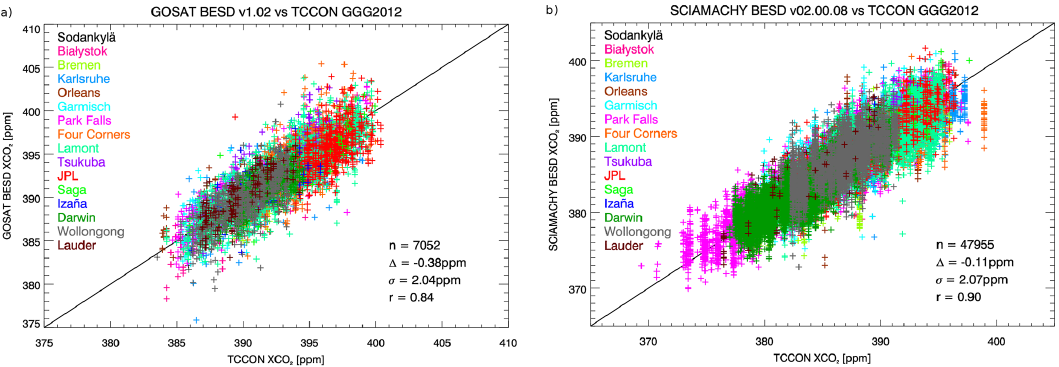
Figure 5. Scatter plots of individual satellite vs. TCCON XCO 2 measurements at the chosen TCCON sites. (a) GOSAT BESD XCO 2 (January 2012–December 2013) vs. TCCON XCO 2 . (b) SCIAMACHY BESD XCO 2 (August 2002–March 2012) vs. TCCON XCO 2 . n is the number of collocations, (cid:49) is the mean difference between the satellite-based data and TCCON, σ is the standard deviation of the difference and r is the correlation